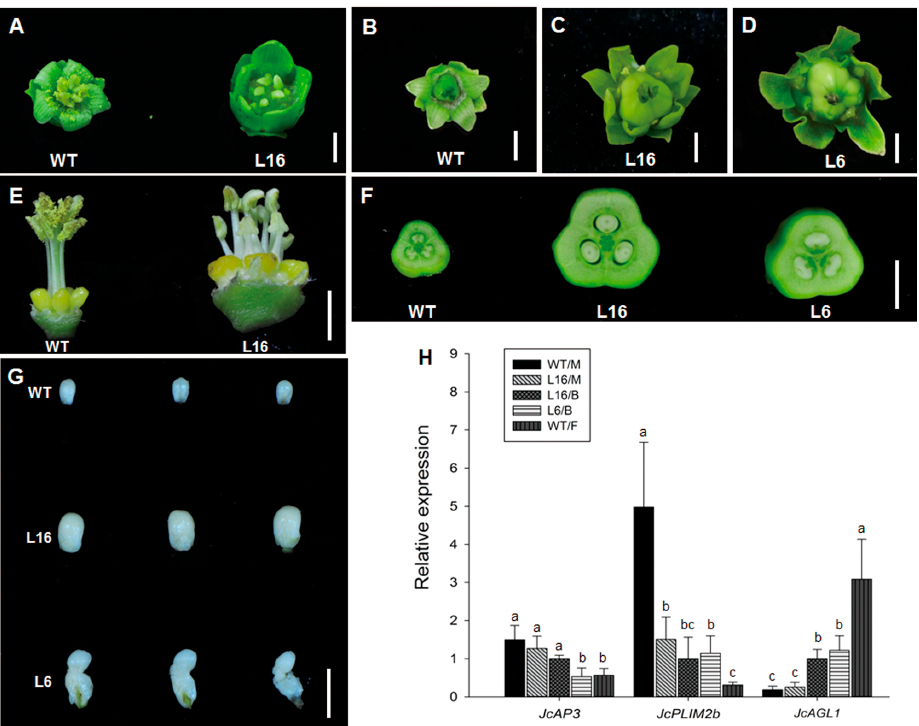
Figure 5. The flowers of JcTM6:AtIPT4 transgenic J. curcas developed abnormally. ( A ) Male flowers of WT and L16 plants. ( B ) Female flower of WT plants. Bisexual flowers of L16 ( C ) and L6 plants ( D ). ( E ) Male flowers of WT and L16 plants with the sepals and petals removed. ( F ) Cross-sections of ovaries of WT, L16, and L6 plants. ( G ) Ovules of WT, L16, and L6 plants. All scale bars = 3 mm. ( H ) Expression of genes involved in floral development in the WT male flowers (WT/M) and female flowers (WT/F), L16 male flowers (L16/M), L16 bisexual flowers (L16/B), and L6 bisexual flowers (L6/B). The values represent the means ± standard deviations ( n = 3). Student’s t -test was used for the statistical analyses. Different letters (a, b and c) indicate significant differences ( p ≤ 0.05).